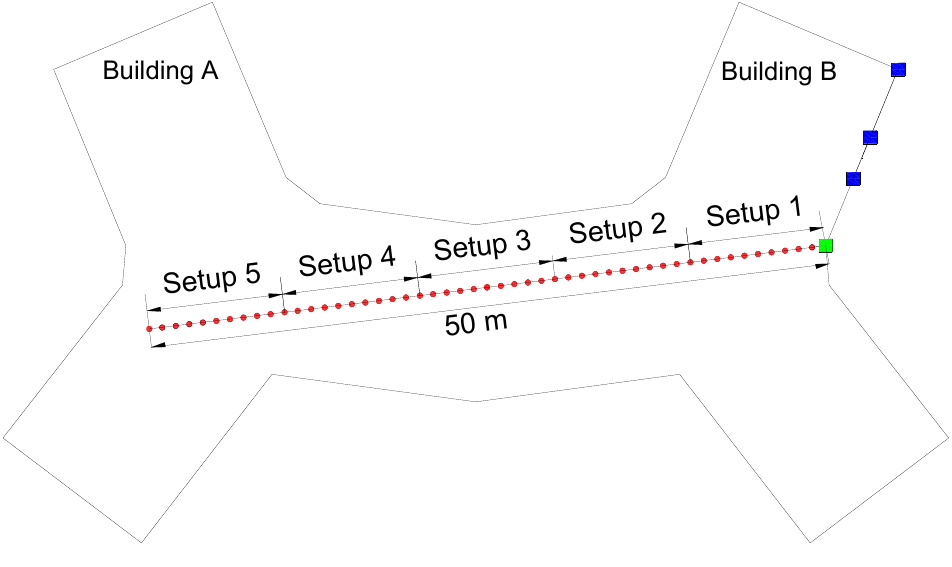
Figure 9. Experimental setup used for low-strain test.